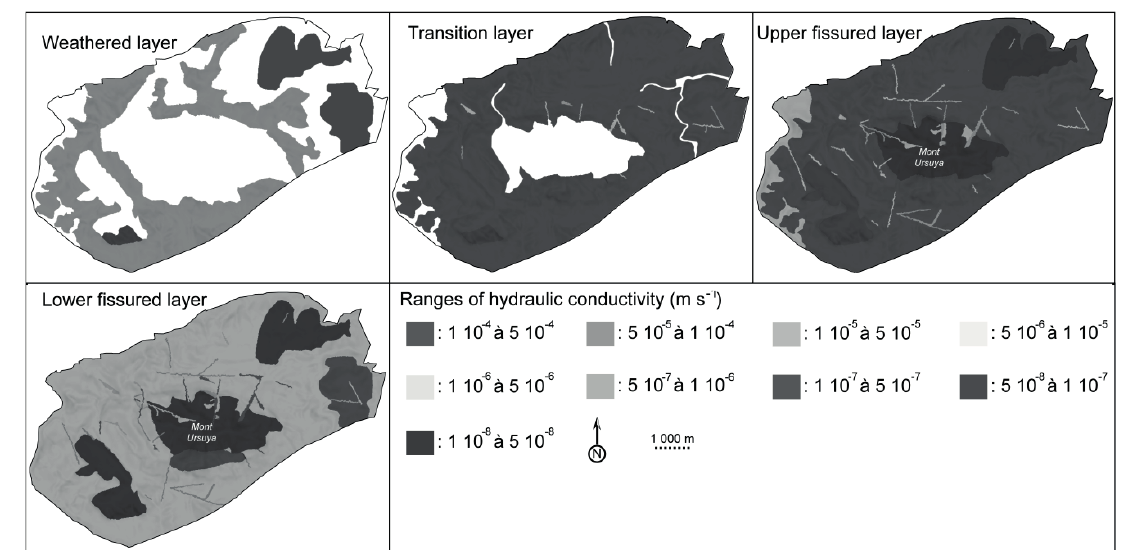
Fig. 3 Maps of hydraulic conductivity of the five horizons after calibration (not shown: hydraulic conductivity of bedrock horizon is homogeneous with a value about 1 × 10 -8 m s -1 ).